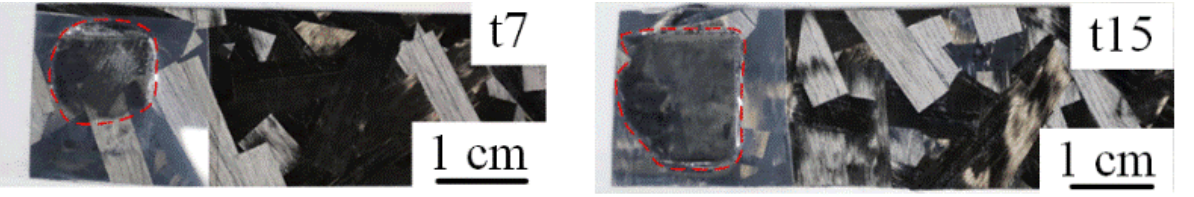
Figure 19. Representative fracture surface of the category 2.